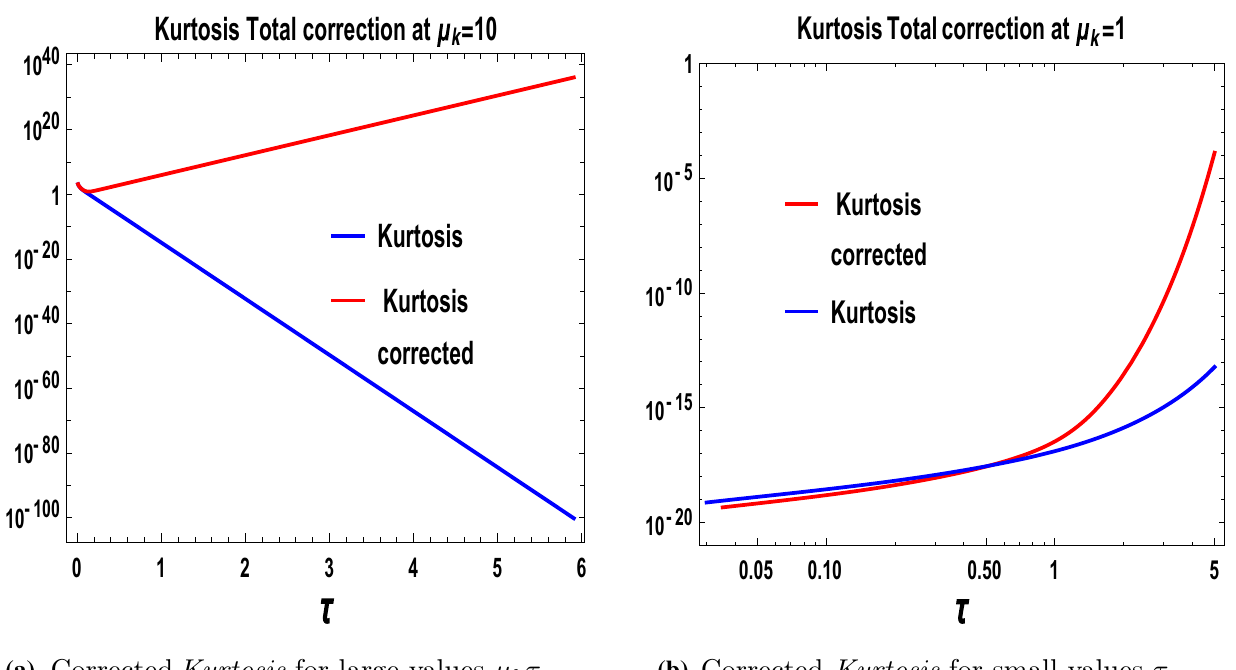
Fig. 54 Time dependent behaviour of Kurtosis without correction and with correction in the probability density distribution function at different range of τ considering different μ